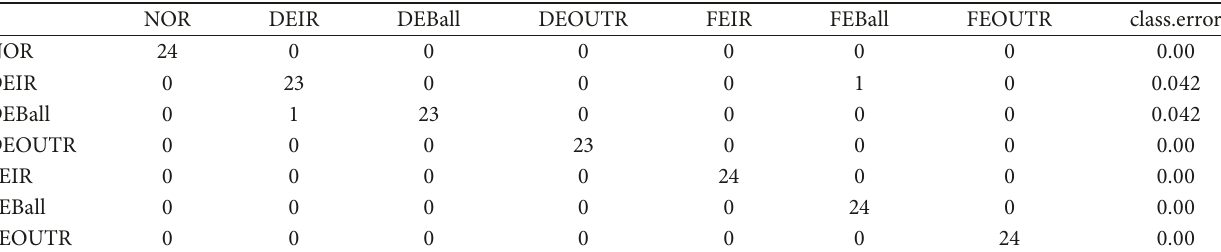
Table 3: Random Forest classification results of wavelet matrix.